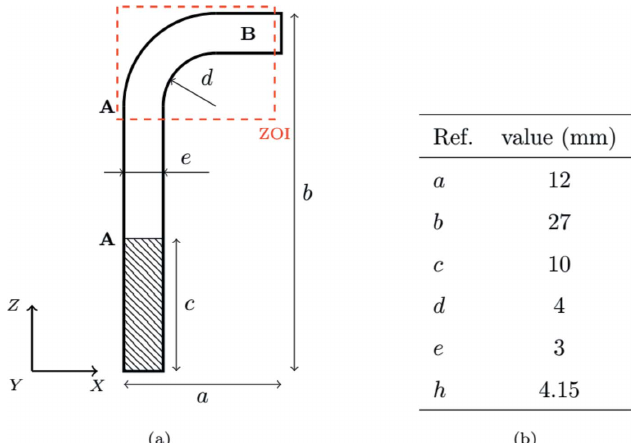
Figure 1 Size of the corner sample. ( a ) The hatched area is the clamping zone. The zone of interest (ZOI) corresponds to the tomographic field of view. The outer surface of the long arm A–A is hot, whereas the short arm B is cold. ( b ) h is the sample width in the direction perpendicular to the view plane in ( a ).